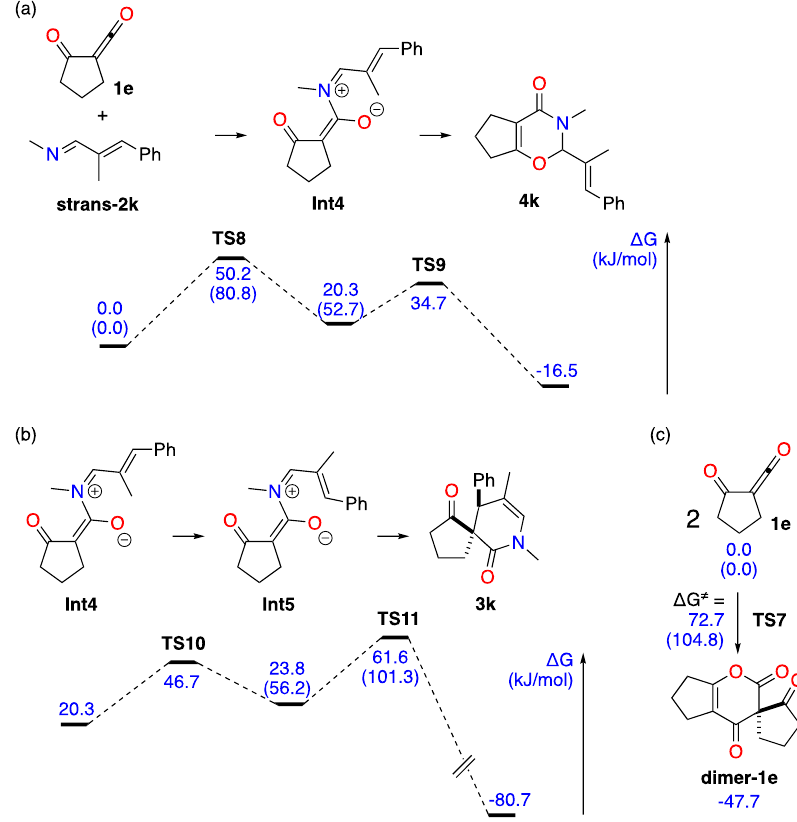
Figure 2. Free Gibbs energy profiles computed at 298 (DFT, B3LYP-D3/6-311++G(d,p)) of the aza-Diels−Alder reactions between the α-oxoketene 1e and the 1-azadiene 2k , and cyclodimerization of α-oxoketene 1e . Free Gibbs energies noted between parentheses were computed at 473 K.